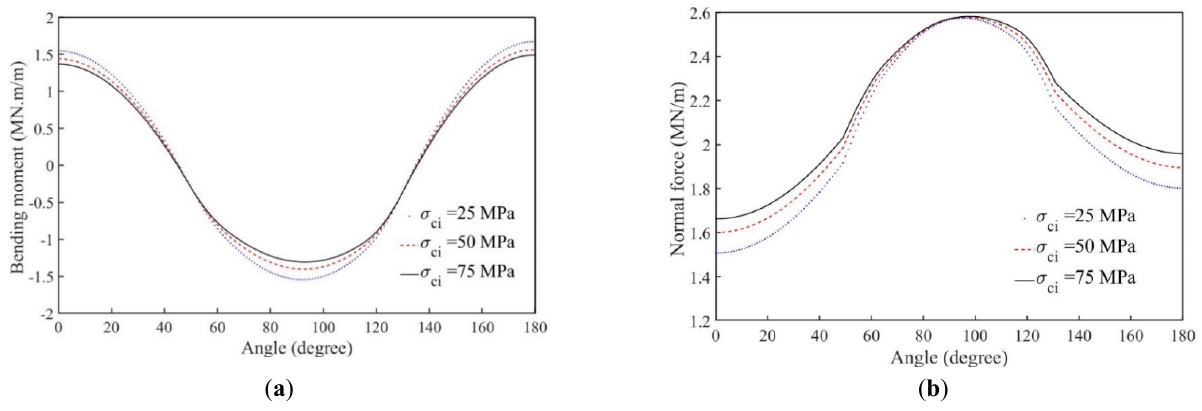
Figure 6. Distributions of internal forces of lining under different σ ci . ( a ) Bending moments M ; ( b ) Normal forces N .